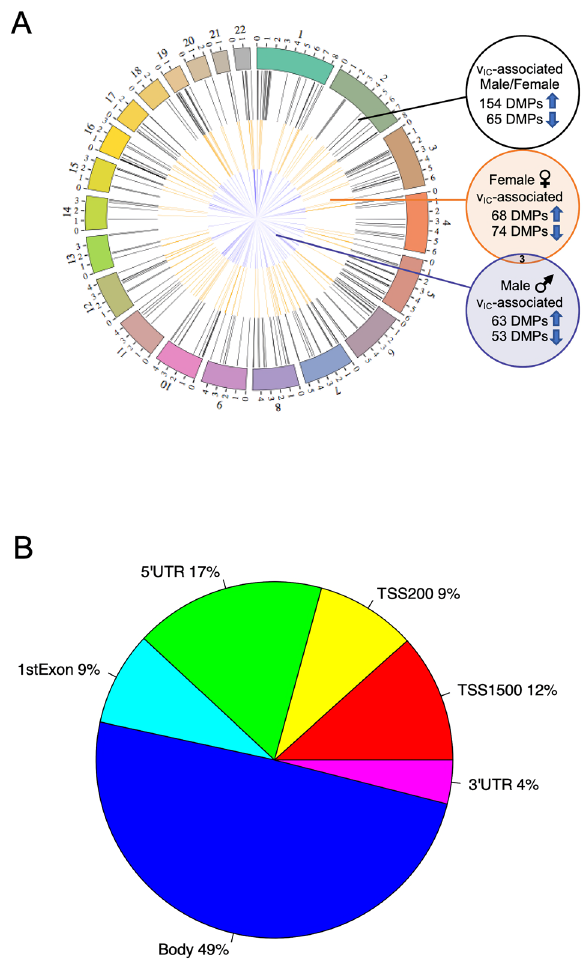
Figure 2. Cord blood DNA methylation levels associated with infant WM microstructure-related changes (ν IC ) showing a sex-by-prenatal maternal depression and anxiety symptom interaction. ( A ) Circos plot depicts genomic distribution of differentially methylated positions (DMPs) across the human genome. (Outer ring) Each chromosome is shown as a different color and the relative chromosome size is represented by the bar length. (Inner rings) Represent the relative location of DMPs across all chromosomes in the full dataset (black), females only (orange), and males only (blue). Sex chromosomes were omitted from the analysis. B) Pie chart showing the percent distribution of DMPs to standard genomic features. 5 ′ UTR = 5 ′ untranslated region’ 3 ′ UTR = 3 ′ untranslated region; TSS = transcription start site; TSS200 = 0–200 bp upstream of TSS; TSS1500 = 200–1500 bp upstream of TSS. Circos plot and pie chart were generated using the R environment 44